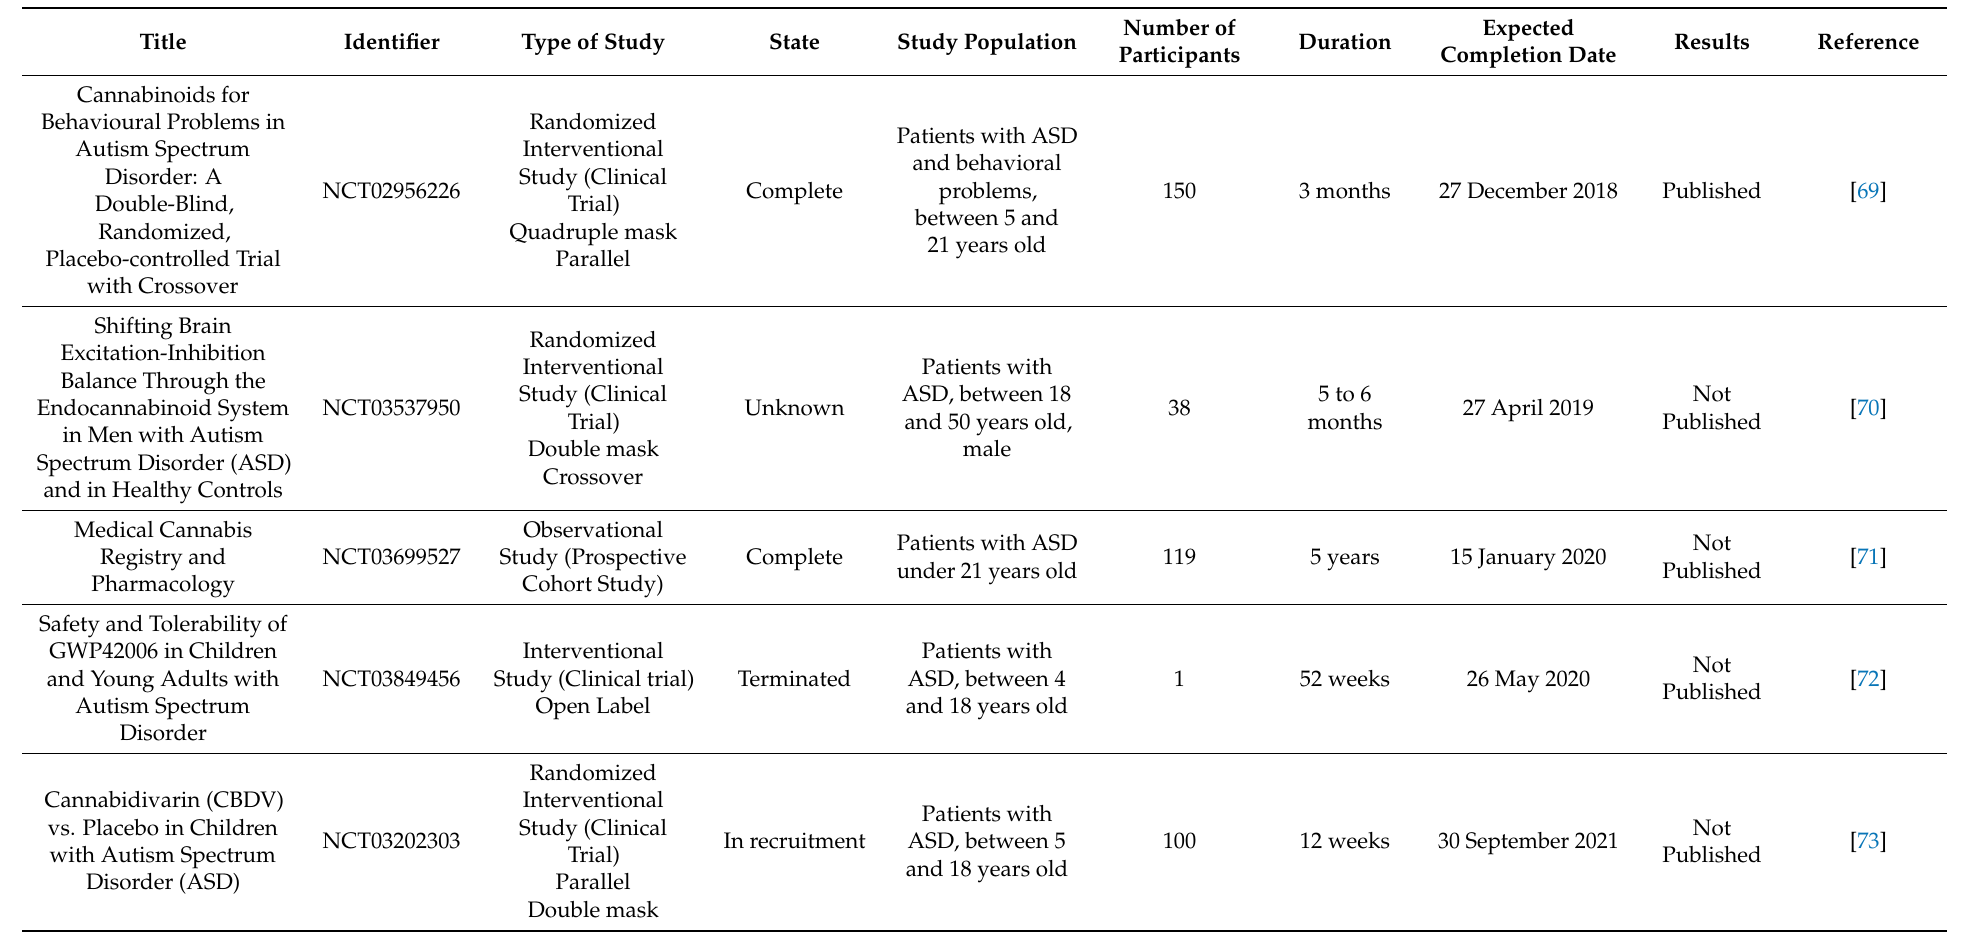
Table 3. Clinical trials